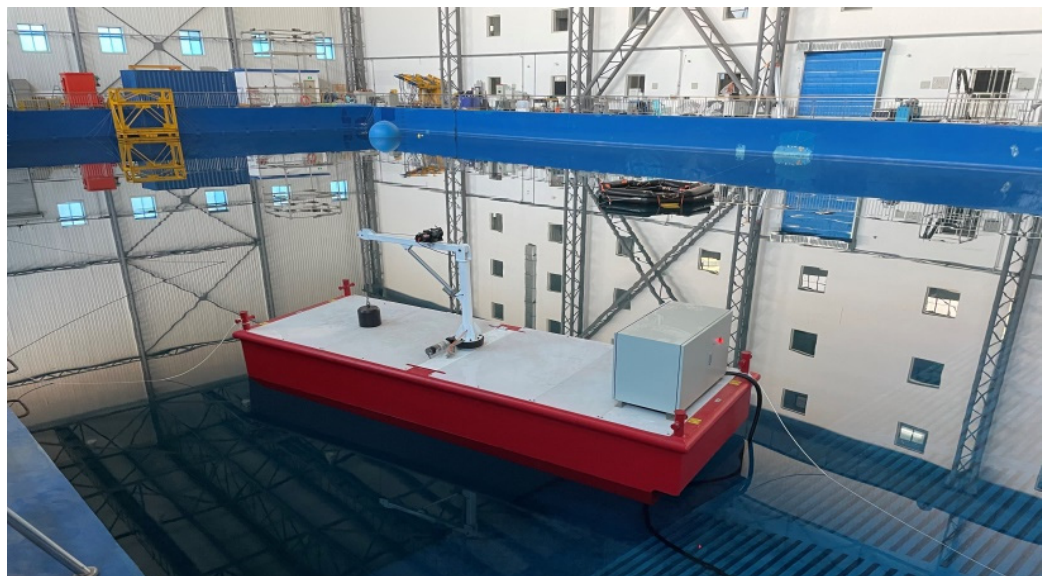
Figure 15. The model of the experimental RFC.